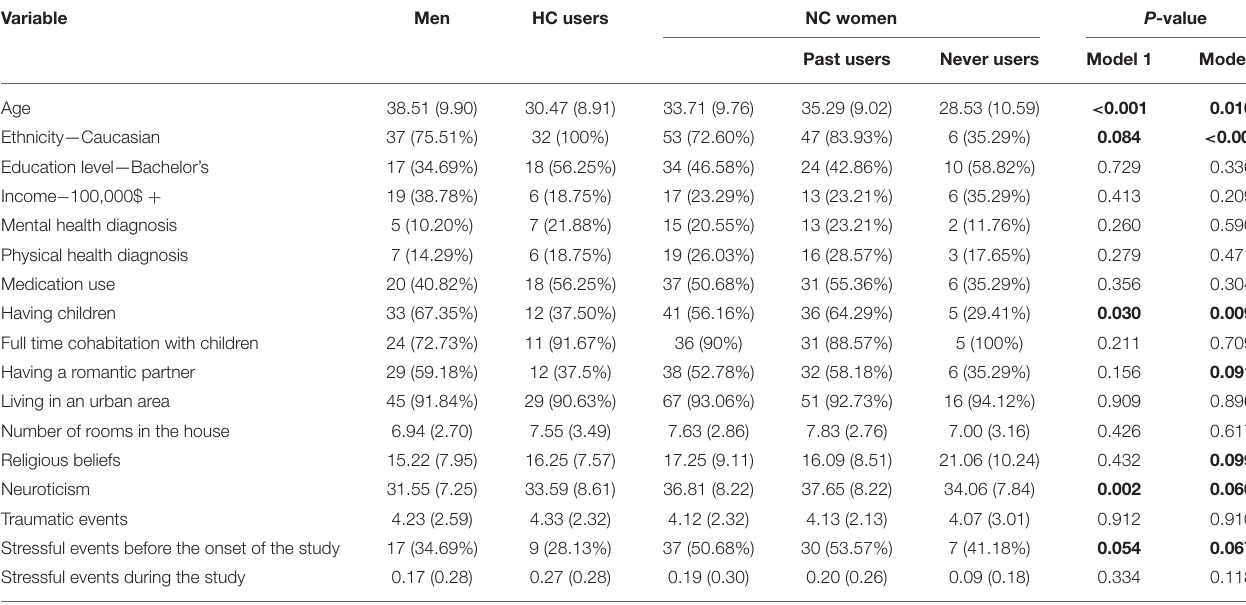
TABLE 2 | Sample characteristics for men, women using HC, and NC women (past and never users).